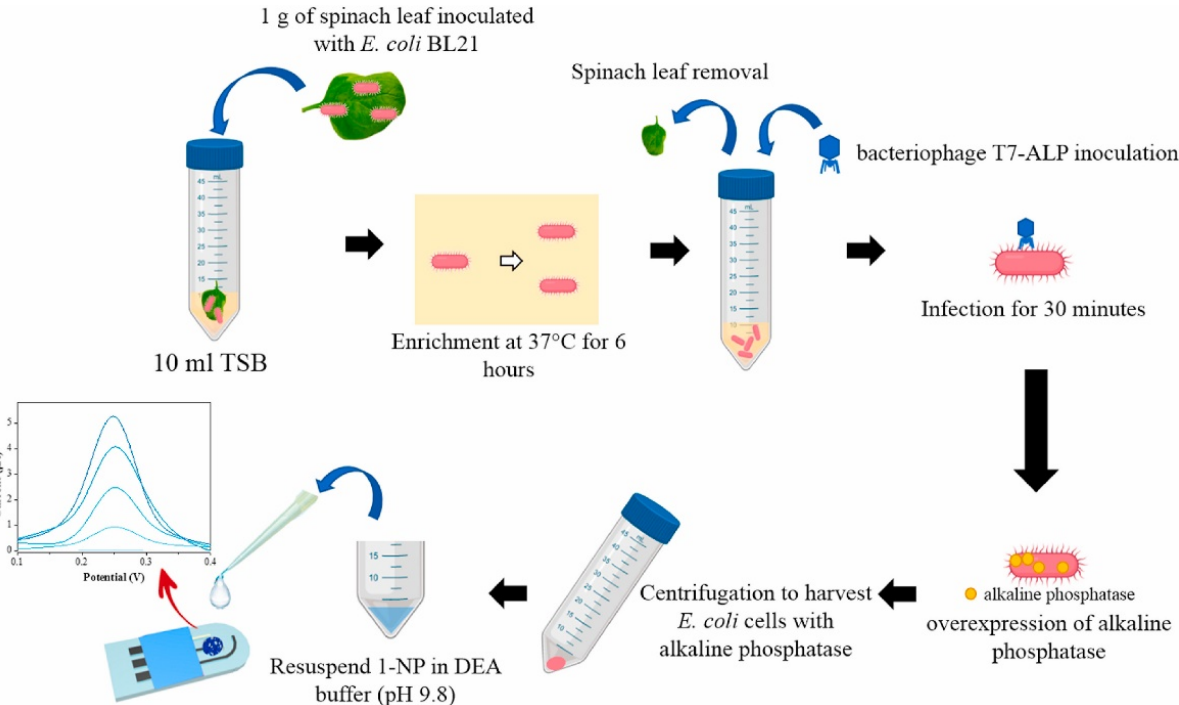
Figure 5. Schematic diagram of a phage electrochemical biosensor for the detection of E. coli on spinach leaves (Reprinted with permission from Ref. [19]. 2022, El ‐ Moghazy et al.).